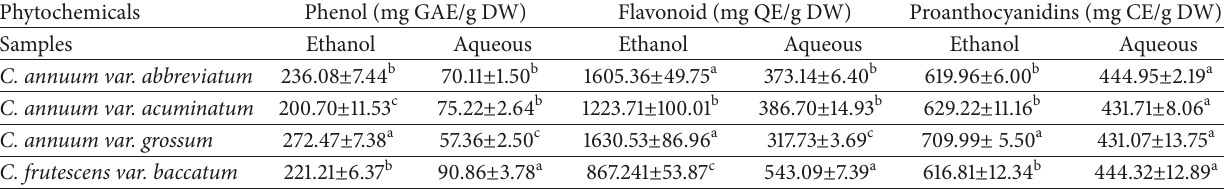
Table 2: Total phenol, flavonoid, and proanthocyanidins contents in the varieties of the cultivated Capsicum species. Phytochemicals